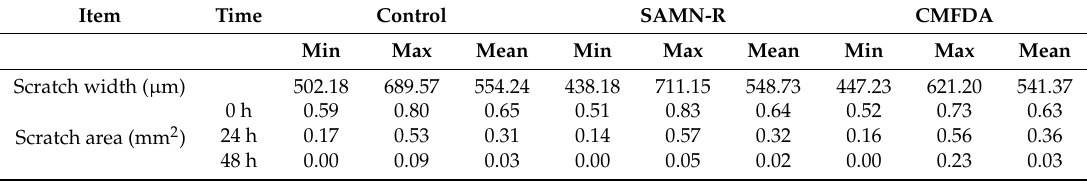
Table 2. Size values of the open area of wide scratch in the wound healing assay experiment.